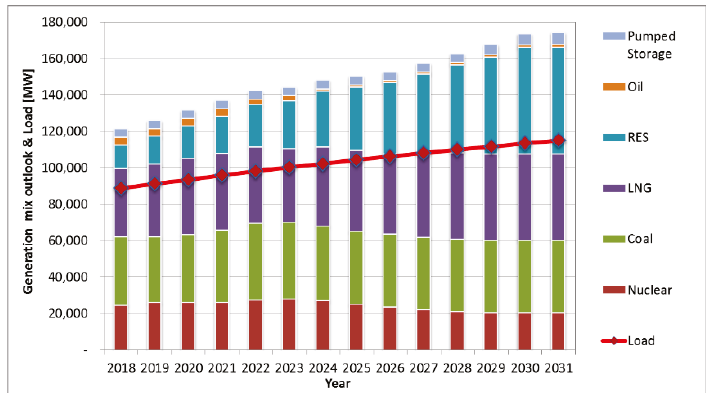
Figure 2. Summary of the Korean Basic Plan for Long-term Electricity Supply and Demand (BPE).